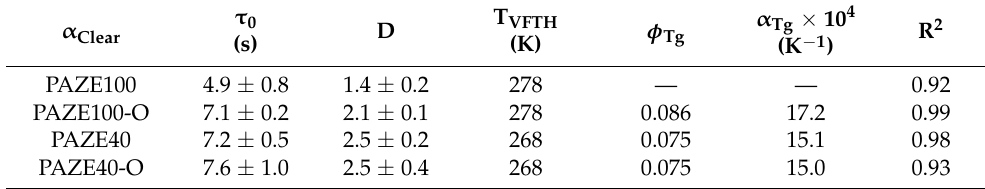
Table 4. VFTH parameters of α Clear relaxation for unoriented and oriented PAZE100 and